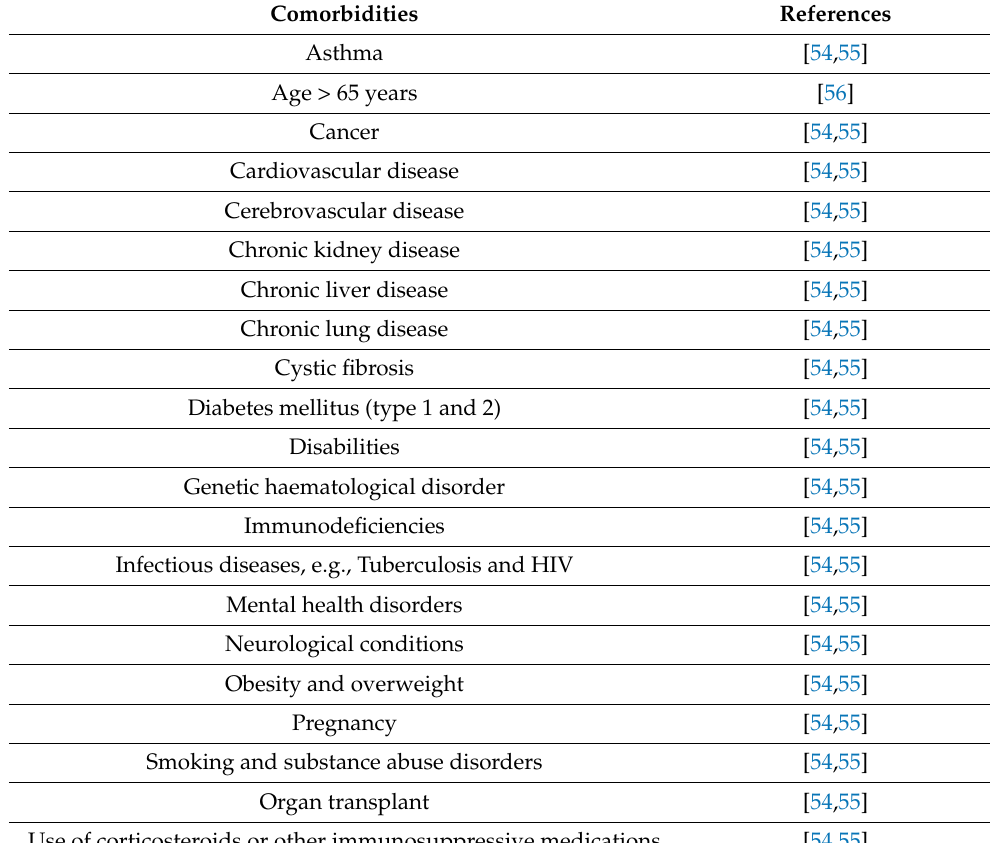
Table 2. Comorbidities associated with COVID-19 severity.